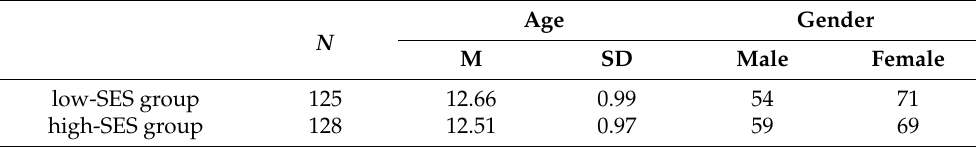
Table 1. Age and gender composition of subjects in two groups. Age Gender N M SD Male Female low-SES group 125 12.66 0.99 high-SES group 0.97 69